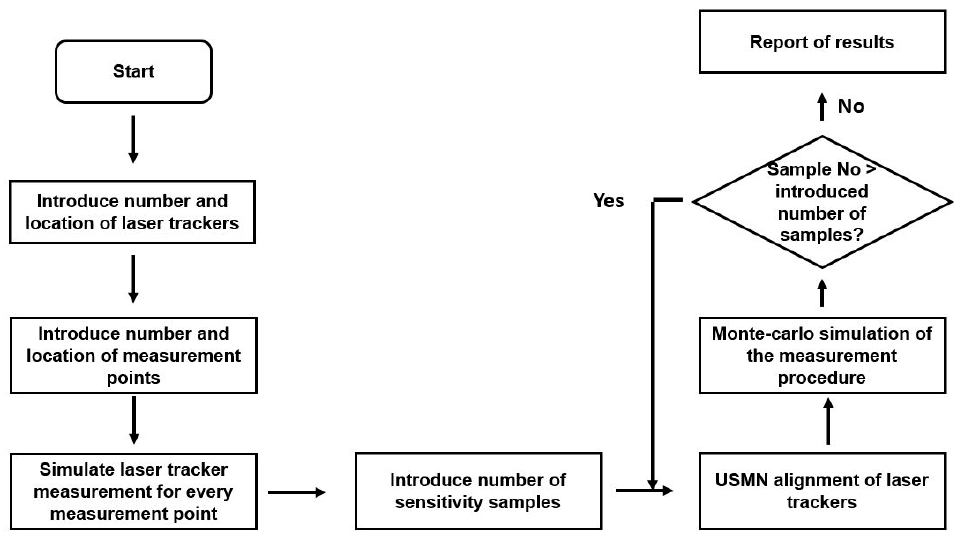
Figure 13. Metrology simulation tool flowchart.